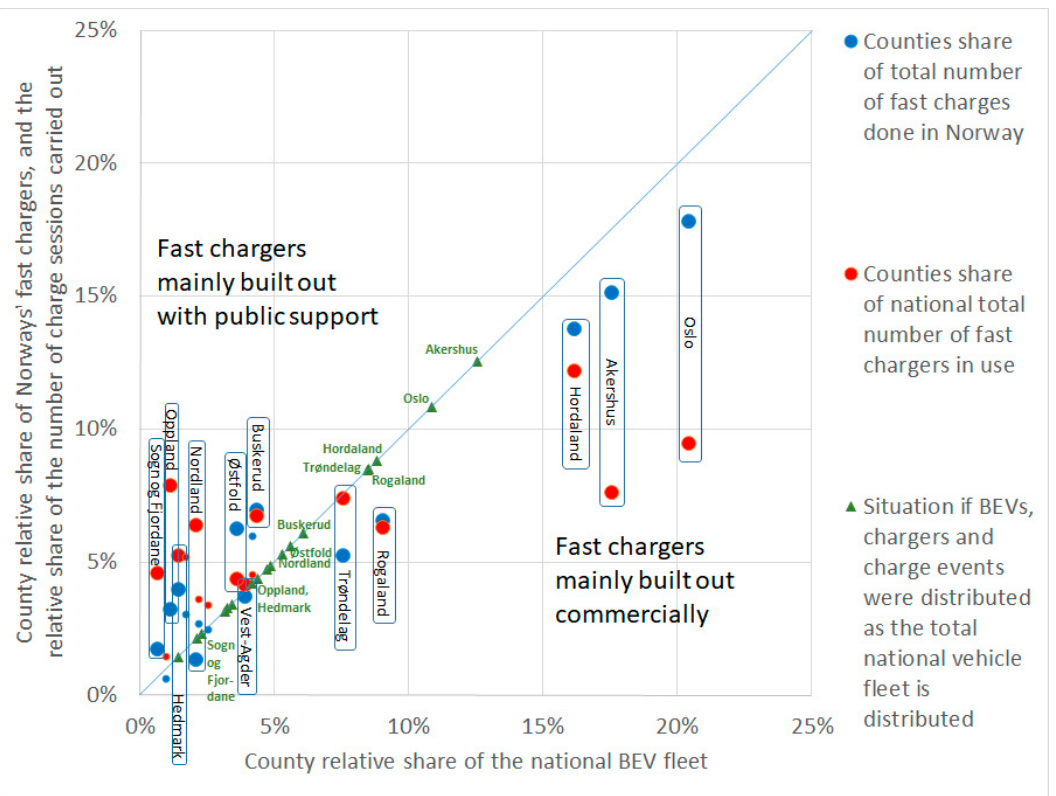
Figure 7. The Counties share of the total national charging volume (fast charge sessions) and installed fast chargers (y-axis) in 2017, and share of BEV fleet in mid-2017 (x-axis). Source: